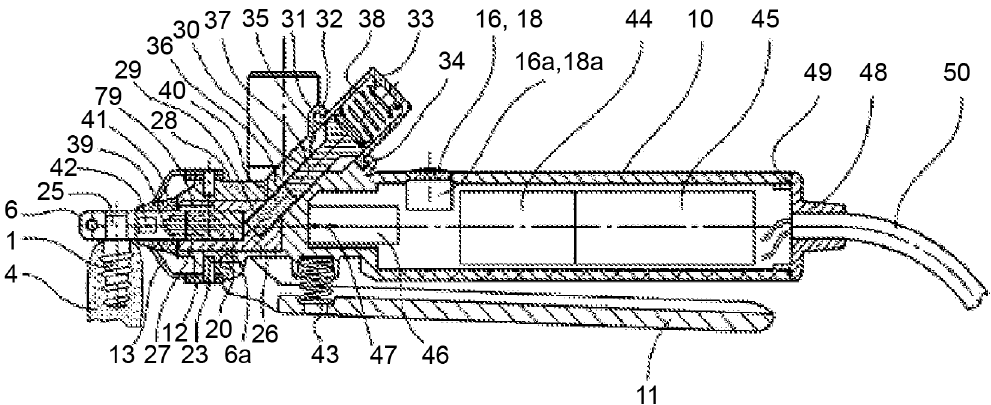
Figure 3. The device consists of a handpiece containing a grip head (6), handle (10), and a secondary clamping system composed of a clamping lever (11) and clamping jaws (12). They can exert clamping forces to the implant (1) in the bone (4). Source: [32].